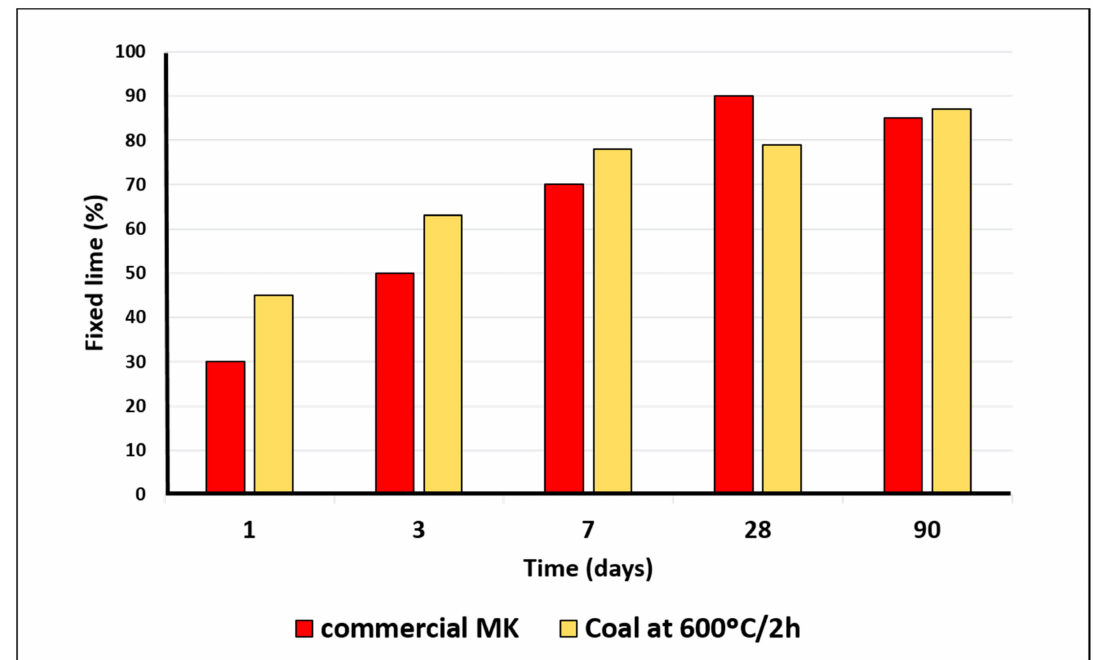
Figure 8. Fixed lime of the thermally activated coal refuse (slap heap) sample at 600 ◦ C/2 h from 1 to 90 days of pozzolanic